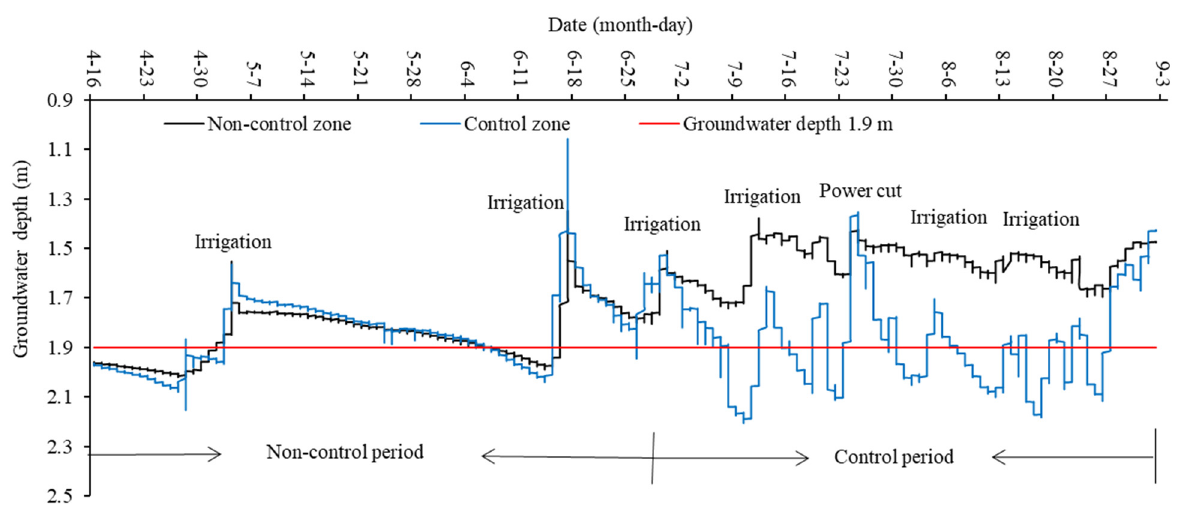
Water 2023 , 15 , x FOR PEER REVIEW Figure 5. Changes in groundwater depths in the control and non-control zones. Figure 5. Changes in groundwater depths in the control and non-control zones.